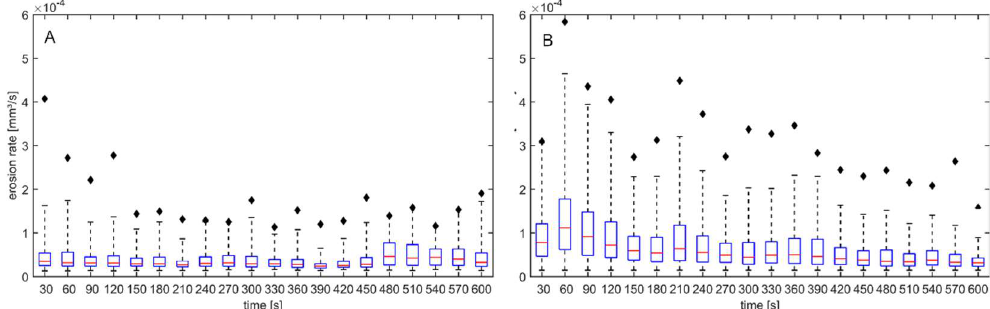
Figure 7. Variability of erosion rates for time intervals of t = 30 s throughout the entire erosion experiments for Q 1 = 7.5 L/s ( A ) and Q 2 = 11.3 L/s ( B ).